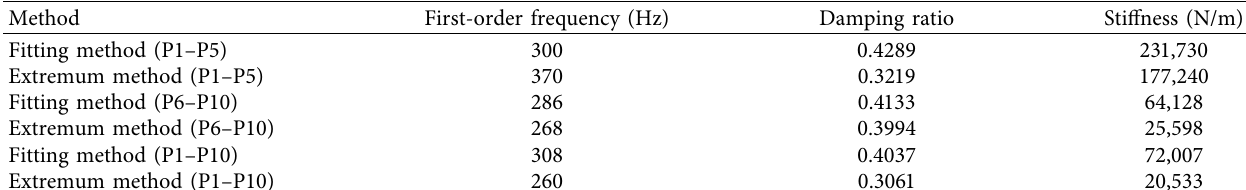
Figure 12. The influence of the extremum and fitting